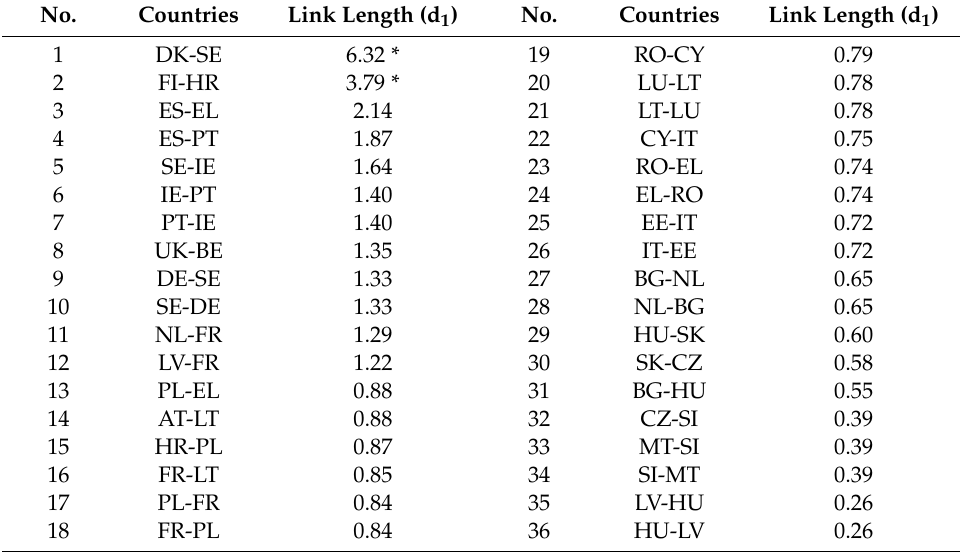
Table 2. Elements of the Wroclaw dendrite—minimum Euclidean lengths between the countries studied. No. Countries Link Length (d 1 ) No. Countries Link Length (d 1